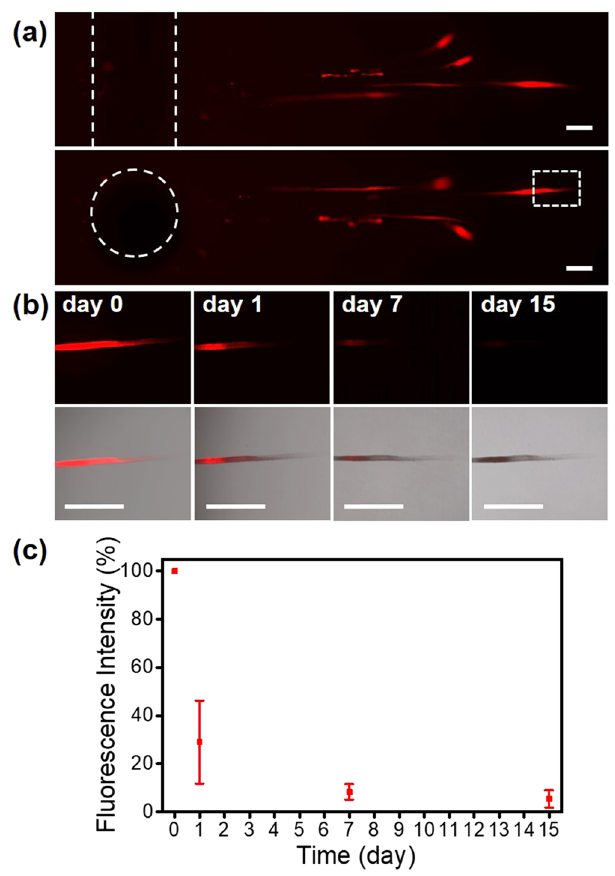
Figure 6. Microscopy images of RhB-mcPLGAs embedded in tissue-mimicking agarose phantoms. ( a ) Representative fluorescent images of the phantoms sliced horizontally and radially to the channel (1.6 mm). ( b ) High resolution of fluorescence, and merged images across 15 days. ( c ) Quantitative analysis of change in fluorescence intensity across 15 days. The points are an average and standard deviation of 3 independent samples. The scale bars represent 500 μ m in ( a , b